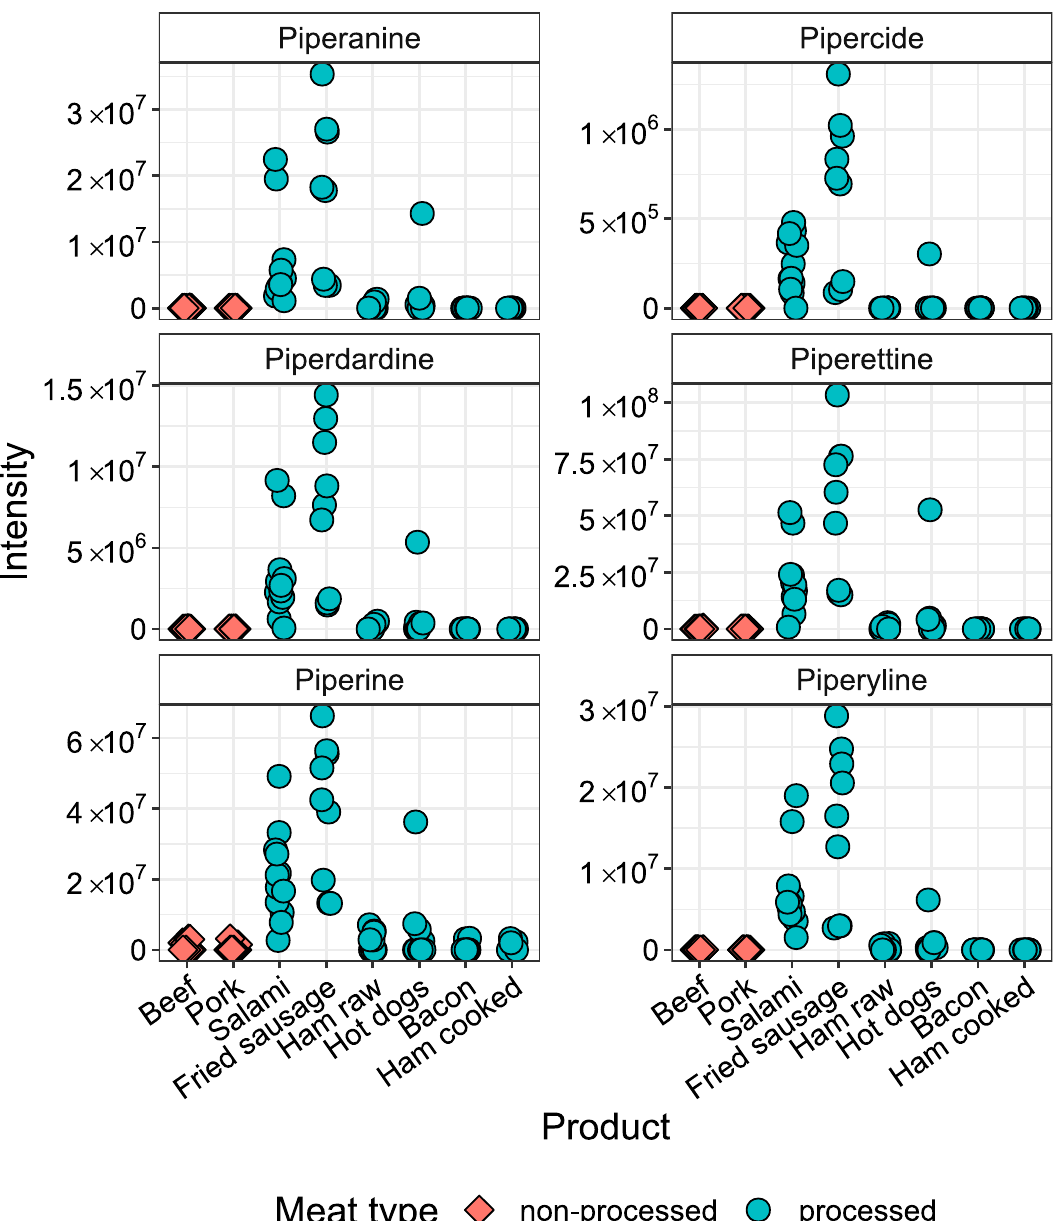
Figure 3. Intensities of pepper metabolites identified in in vitro digests of meat products. All compounds are significantly elevated (FDR-adjusted p -value < 0.05) in processed meat products ( n = 63) compared to non-processed red meat products ( n = 36).